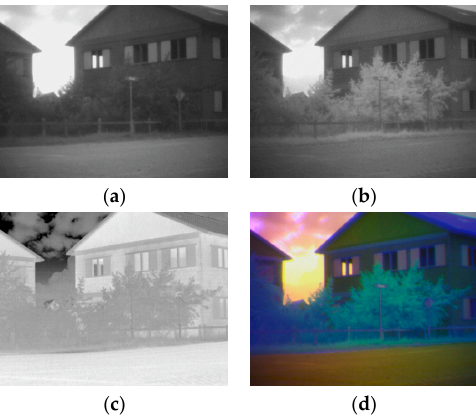
Figure 1. Example from the total training set of six images. ( a ) Visual sensor band; ( b ) near infra-red (NIR) band; ( c ) longwave infrared or thermal (LWIR) (thermal) band; and ( d ) RGB-representation of the multiband sensor image (in which the ‘hot = dark’ mode is used).